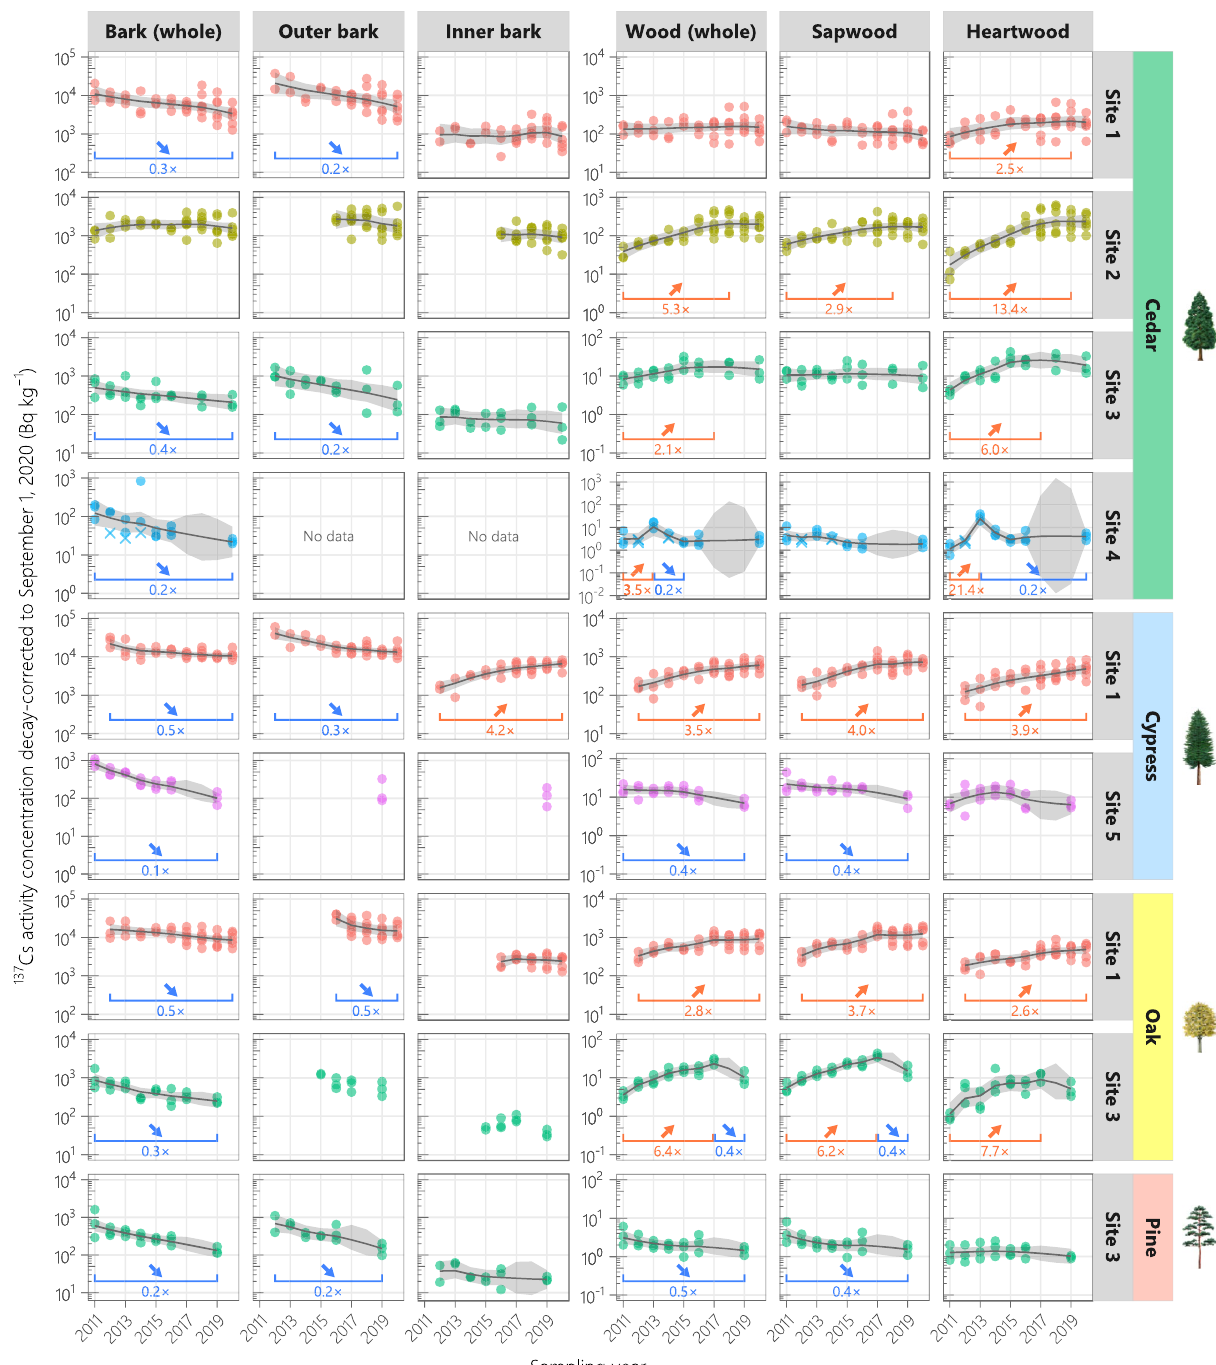
Figure 2. Temporal variations in 137 Cs activity concentrations (decay-corrected to September 1, 2020) in the bark and wood of the monitoring trees. Circles show the observed values, and crosses indicate that the 137 Cs concentration was below the (shown) detection limit. The true states were estimated using a dynamic linear model, and the median values and 95% credible intervals are shown by solid lines and shaded regions , respectively. Horizontal lines indicate significant differences between the estimated true state values in the years at both ends (delimiting years). Data on the bark (whole), wood (whole), sapwood, and heartwood from 2011 to 2016 were provided in previous studies 8,25,31 decrease rate seen in the site-1 cypress plot. Further studies are needed to understand the 137 Cs concentration in newly formed outer bark and to determine the 137 Cs CR of outer bark/inner bark at steady state.